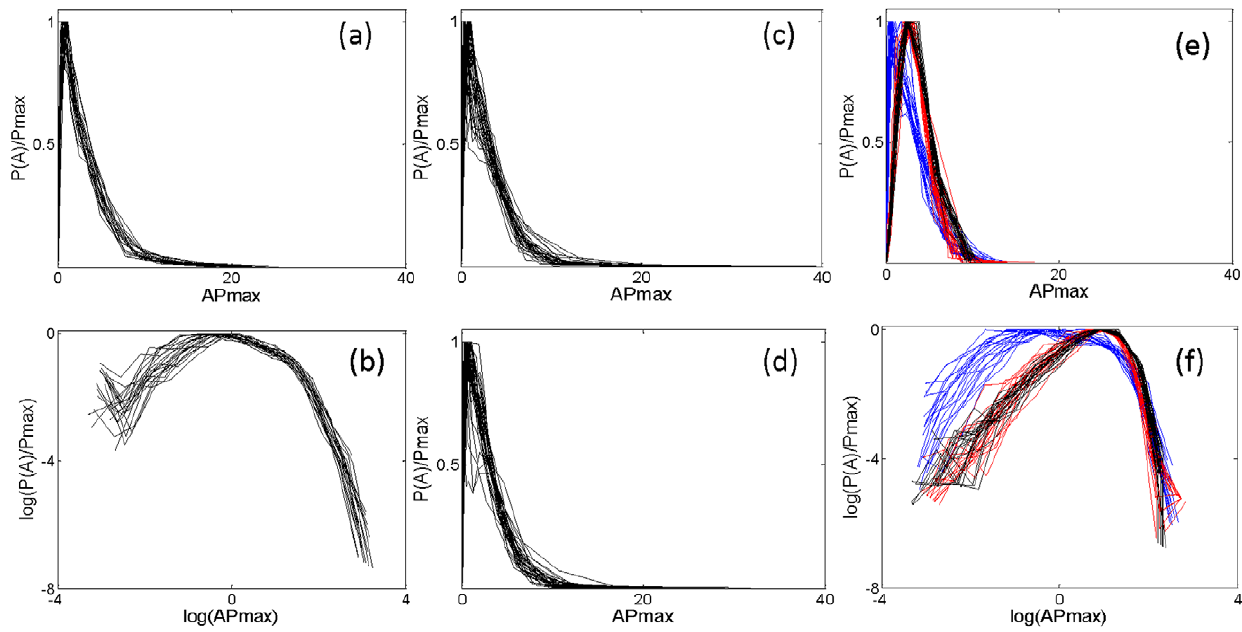
Figure 2. Probability distribution P(A) of amplitude, A , obtained by wavelet analysis of motility data. ( a ) Rescaled distributions, normalized to provide unit area by rescaling using P max , of amplitude at a range of time-scales up to 2 h from a subject considered to be at low risk for BD by GBI criteria. ( b ) The same data, log-transformed and showing a long-tail, which share most of the values of log ( AP max ). ( c ) Amplitude distribution at a specific scale (s=0.54 h) for 35 subjects considered to be at low risk for BD by GBI criteria. ( d ) The same for 35 other subjects at high risk for BD. ( e ) Amplitude distribution up to 2 h for a subject at high risk for BD (blue line) and the corresponding surrogate data (red line); the amplitude distribution (black line) obtained from the wavelet analysis of data derived from a Gaussian distribution follows the amplitude distribution of surrogate data. ( f ) Log-transformed amplitude from panel e ; here, wavelet amplitudes of Gaussian as well as surrogate data have identical distributions without a long-tail, and differ from the distribution of the original